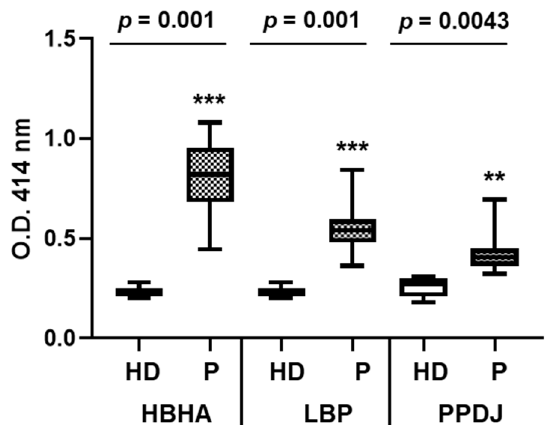
Figure 7. Human serum antibody levels to HBHA and LBP from M. intracellulare . ELISA were performed on plates coated with PPDj, HBHA or LBP purified from M. intracellulare . The panel of sera tested included 6 healthy donors (HD) and the 17 patients included in this study (P). Serum samples were realized in triplicate. Statistical analysis was performed with Tukey’s multiple comparison tests. **, p < 0.005, ***, p = 0.001.